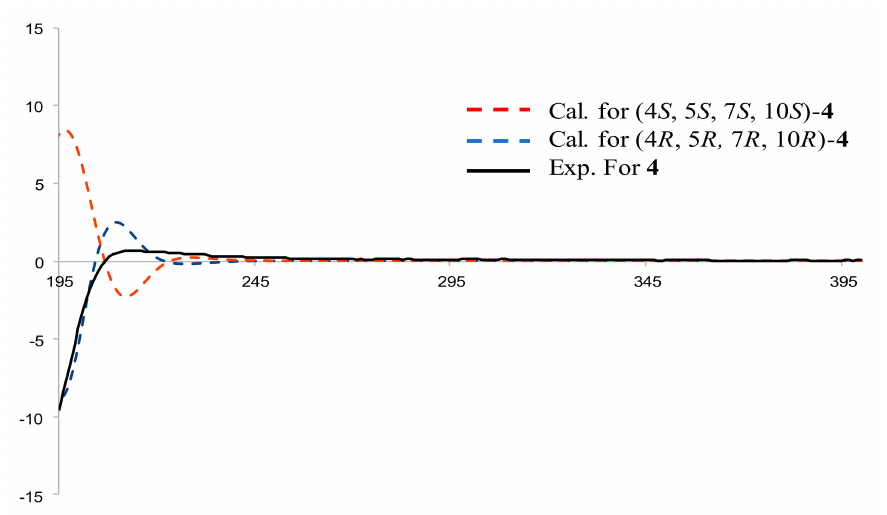
Figure 11. Comparison of the calculated ECD spectrum for (4 R , 5 R , 7 R , 10 R ) − 4 at B3LYP/6-31G(d) level with the experimental spectrum of 4 in MeOH. σ = 0.3 eV, shift = +22